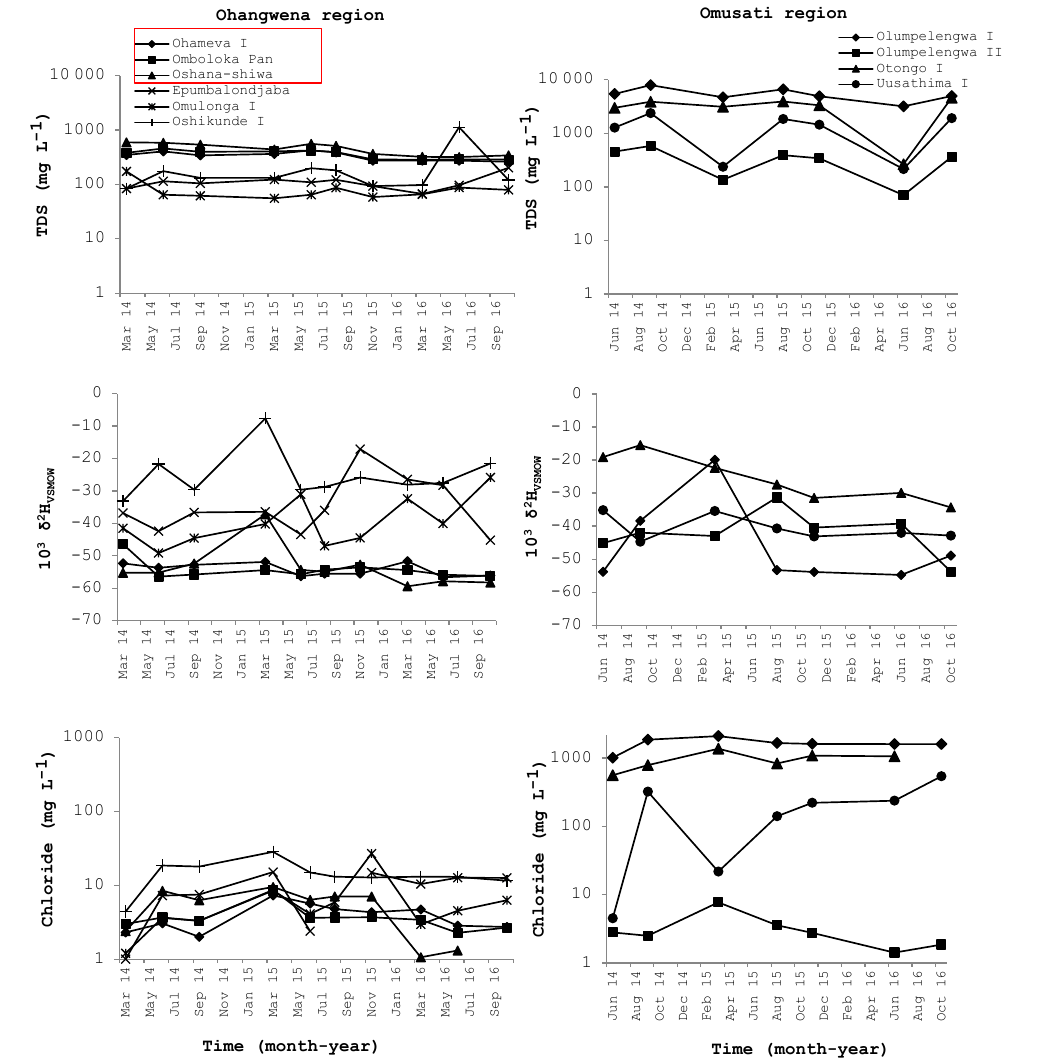
Figure 5. Temporal variation of TDS, δ 2 H and chloride concentrations of shallow groundwater in Ohangwena and Omusati regions. The villages in the red box represent deep wells from the